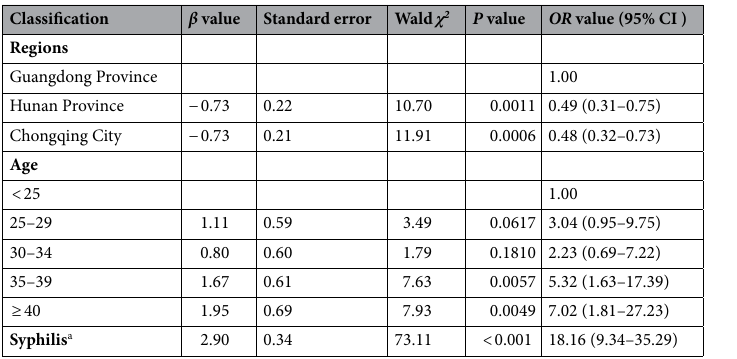
Table 3. Multivariate Logistic regression model analysis of HCV associated factors among pregnant women in three provinces. a "No" was used as the reference group.